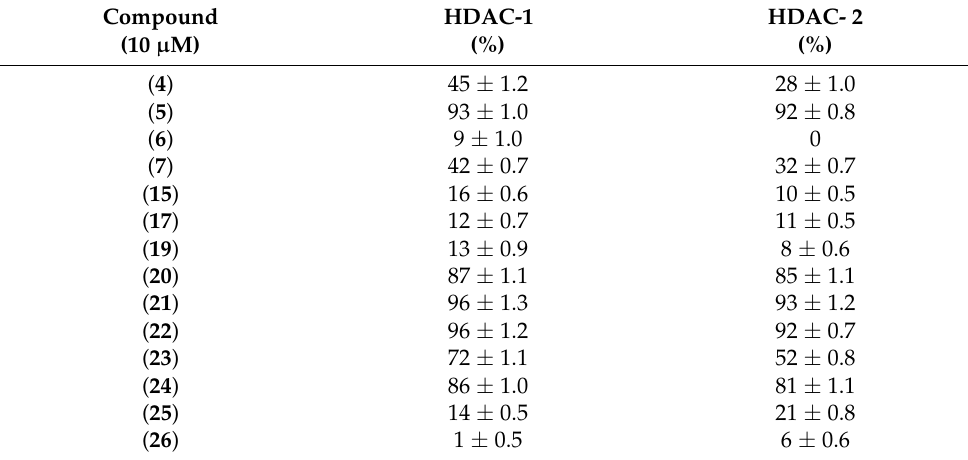
Table 2. Initial enzymatic inhibition screening of compounds ( 4 )–( 7 ), ( 15 ), ( 17 ), ( 19 ), ( 20 )–( 24 ), ( 25 ), and ( 26 ), against HDAC-1 and